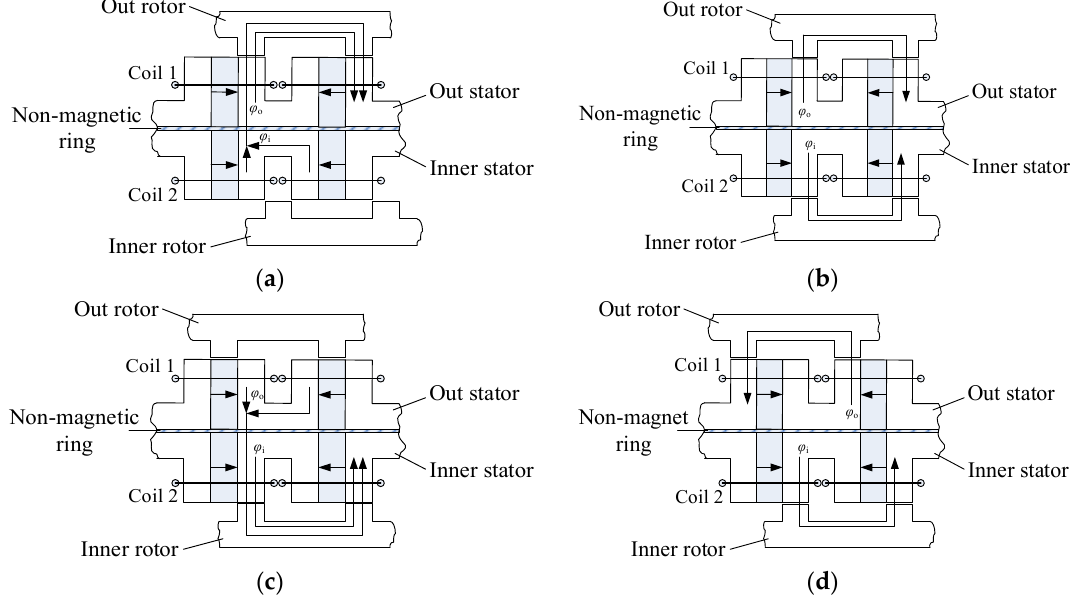
Figure 4. Principles of magnetic couplings. ( a ) Position A; ( b ) Position B; ( c ) Position C; ( d ) Position D.